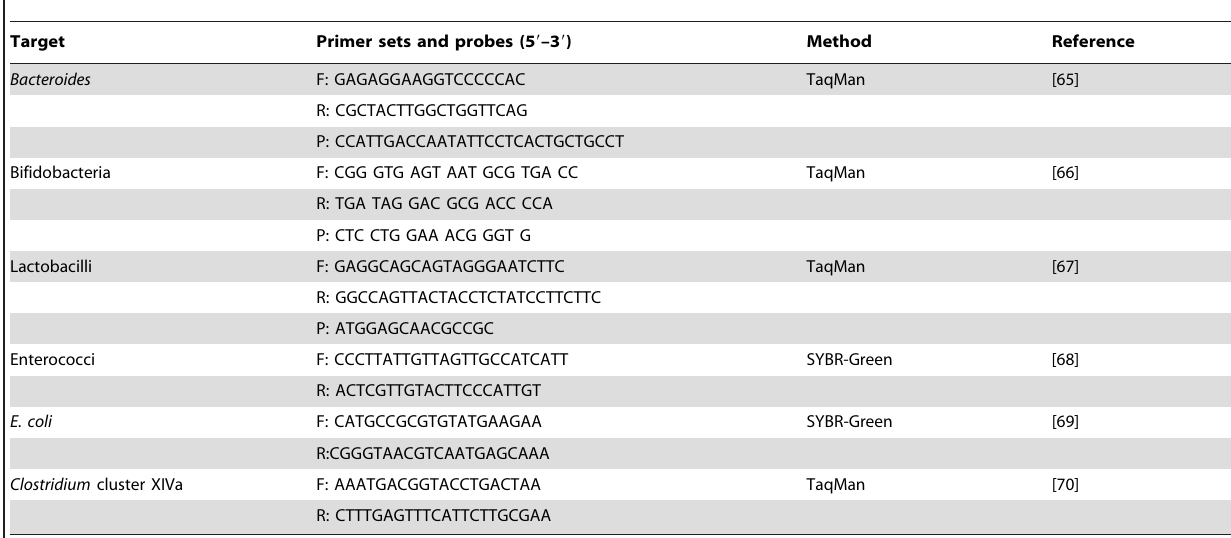
Table 1. Primers and probes used for detecting bacterial groups in faecal samples.